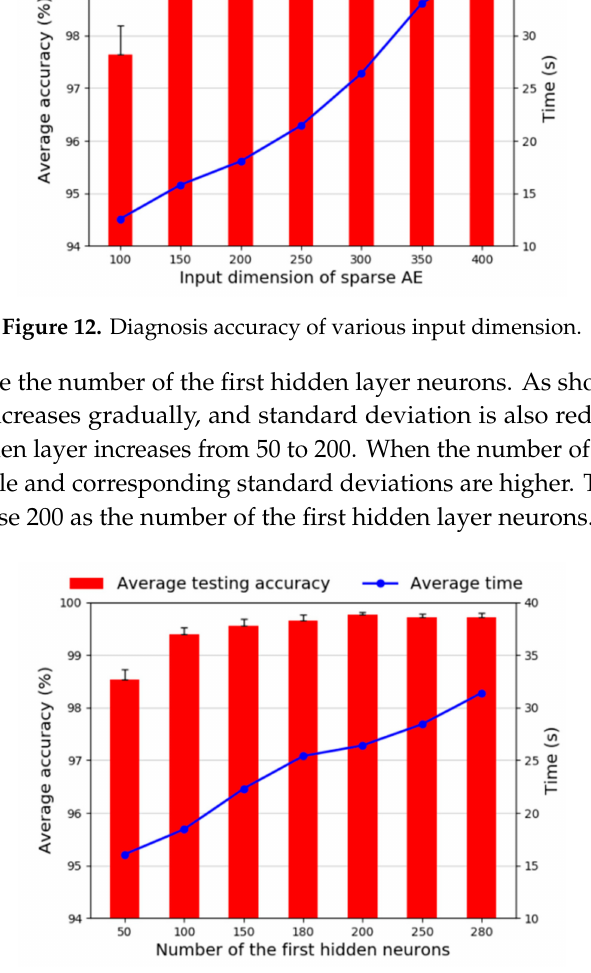
Figure 13. Diagnosis accuracy of neurons in the first